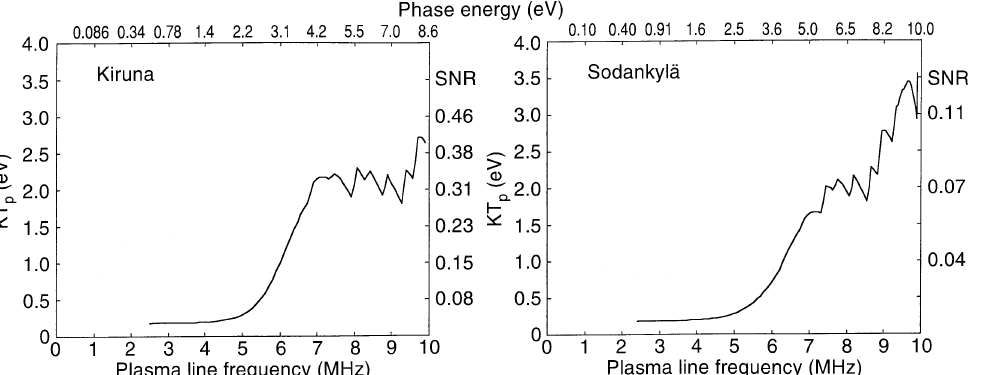
Fig. 6. Predicted plasma line strength for the EISCAT UHF remote sites (Kiruna and Sodankyla¨ ) for daytime and 250 km altitude. The left y - axis gives the plasma line temperature in eV, the right y - axis the signal-to-noise ratio for a typical experimental configuration (see